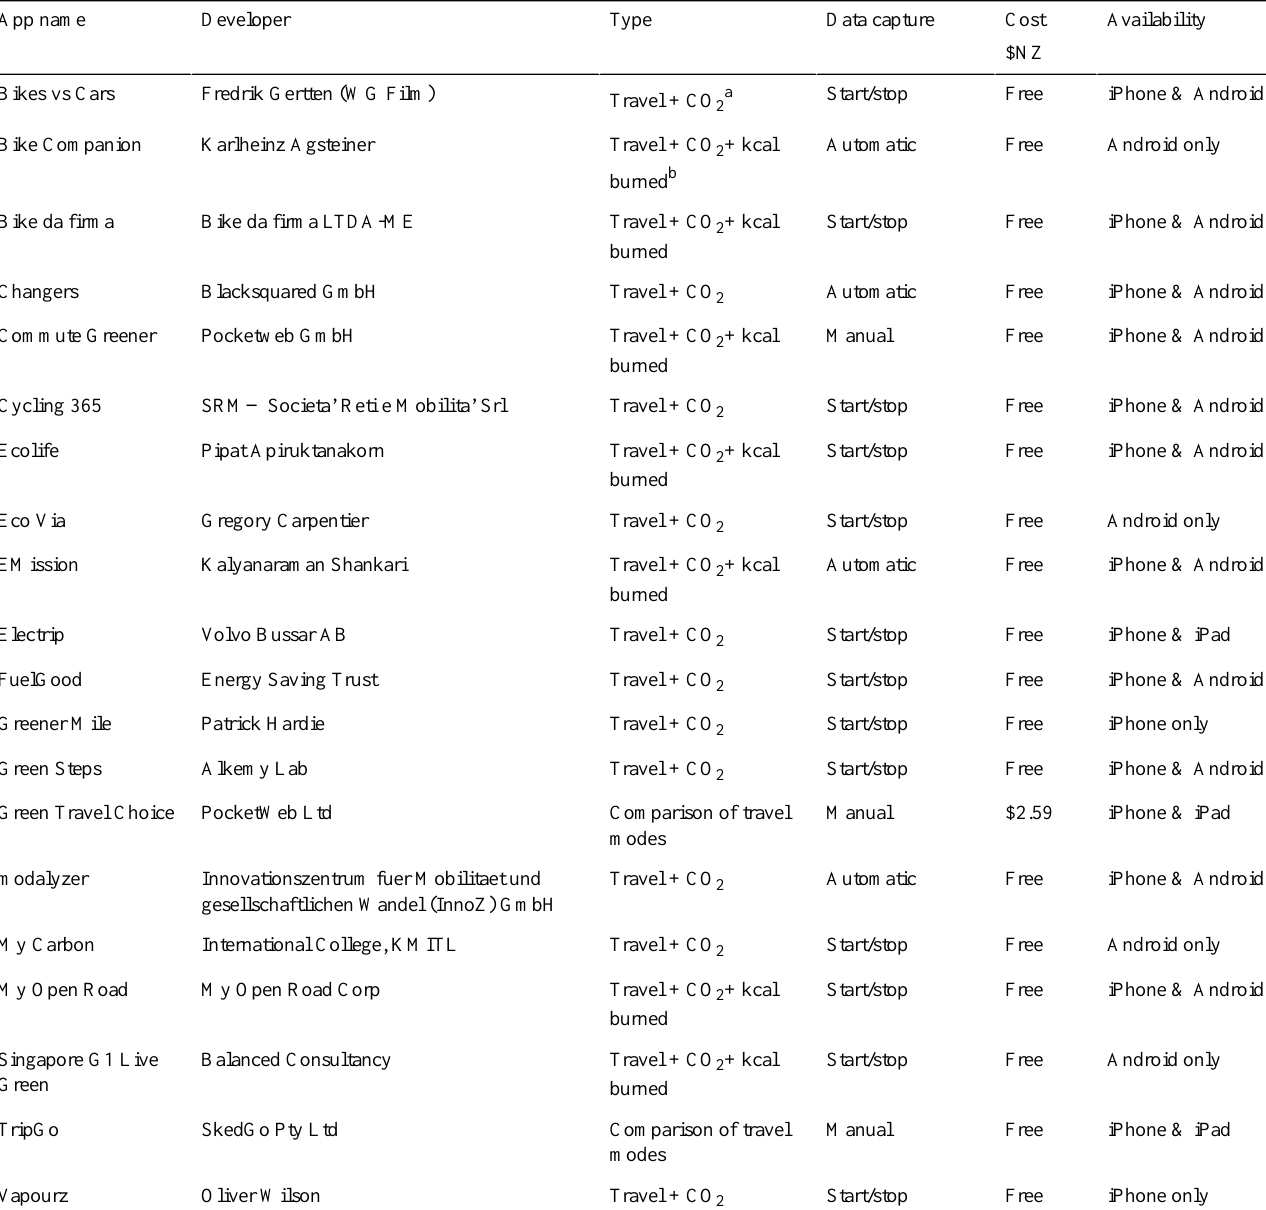
Table 3. App name, developer, type of app, method of data capture, cost, and availability of transport-related